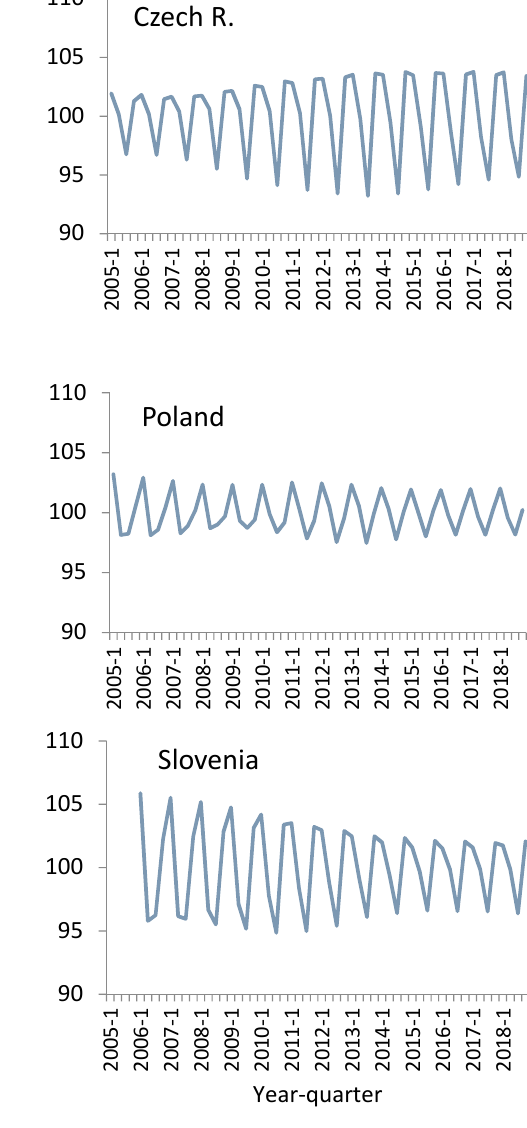
Figure 6. Seasonal fluctuations of beech roundwood prices in selected European countries in 2005– 2018.